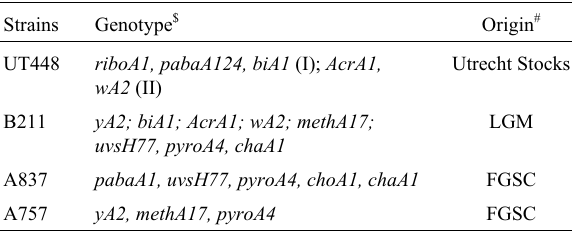
Table 1 - Genotype and origin of Aspergillus nidulans